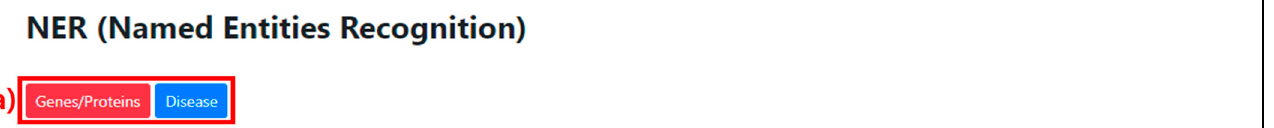
Figure 8. Abstract result screen on web page after PMID input.